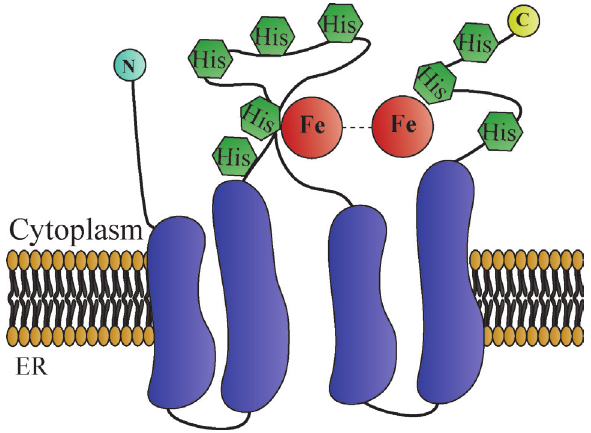
Stearoyl-coenzyme A desaturase 1 (SCD1) is an iron-containing transmembrane enzyme. SCD1 protein is exclusively localized on the ER membrane